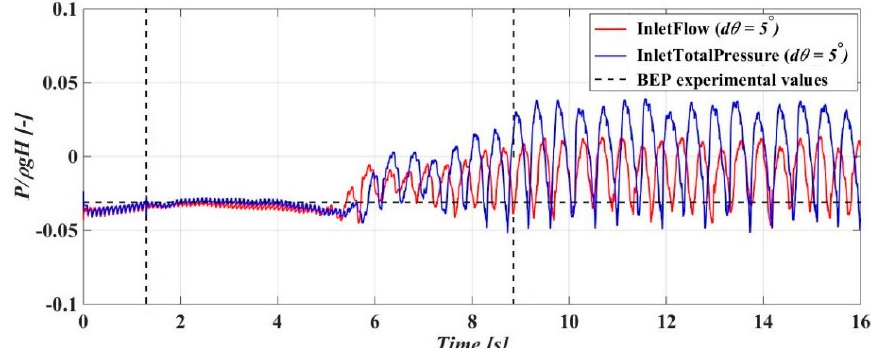
Figure 11. Pressure–time variation (monitor point 3c in the draft tube domain). The dotted horizontal line represents the mean pressure measured at the BEP. The dotted vertical lines represent the start and the end of the guide vane closure.